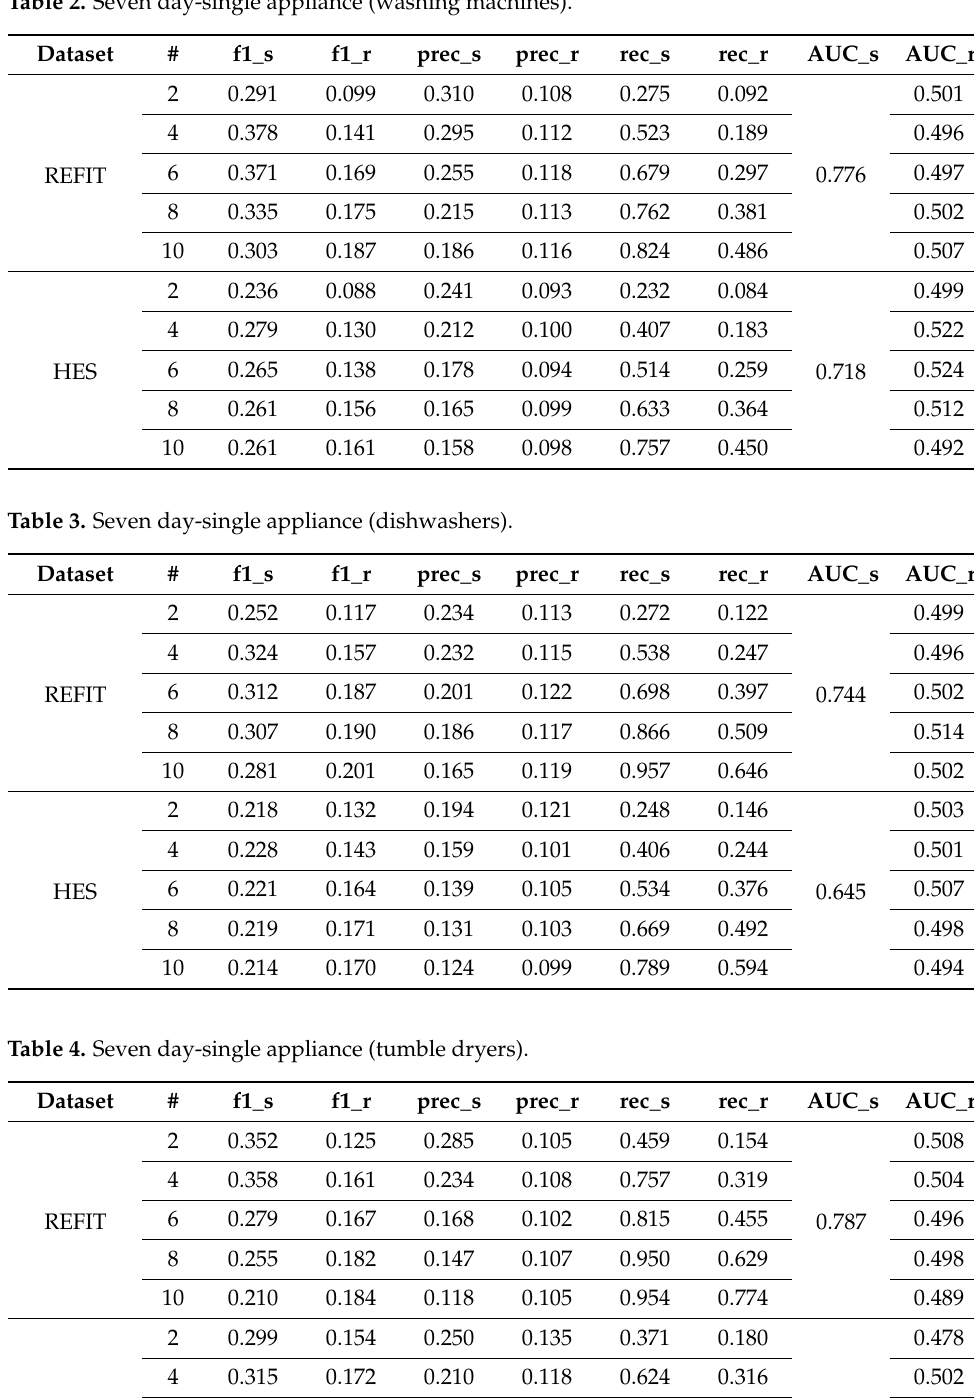
Table 2. Seven day-single appliance (washing machines).